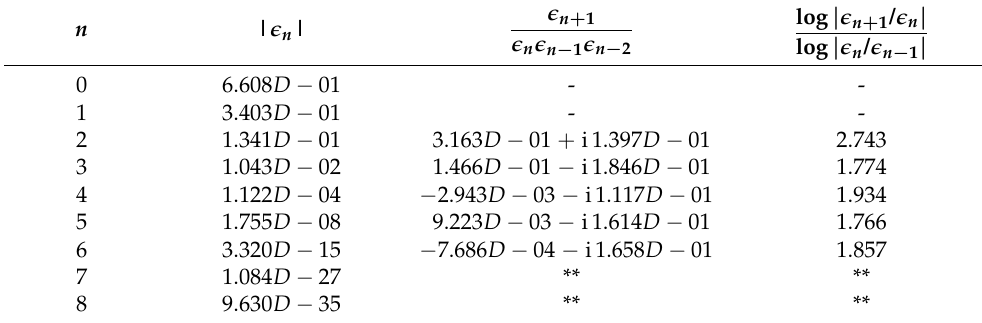
Table 2. Results obtained by applying the generalized secant method with k = 2, as shown in (34) and (35), to the equation sin ( i z ) − cos z = 0, to compute the root α 0 = ( 1 − i ) π /4. The entries denoted “**” mean that the limit of the extended-precision arithmetic has been reached. (cid:101) n + 1 log | (cid:101) n + 1 / (cid:101) n n | (cid:101) n | (cid:101) n (cid:101) n − 1 (cid:101) n − 2